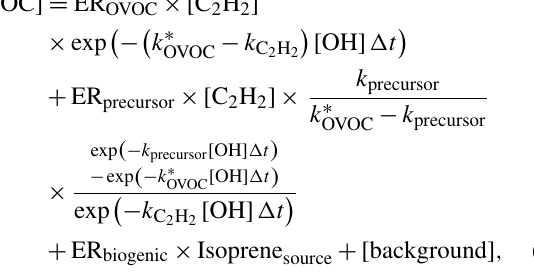
Figure 4. Average mass spectra obtained by PTR-ToF-MS from ambient measurements during the campaign. The different ion cat- egories are discussed in the text in